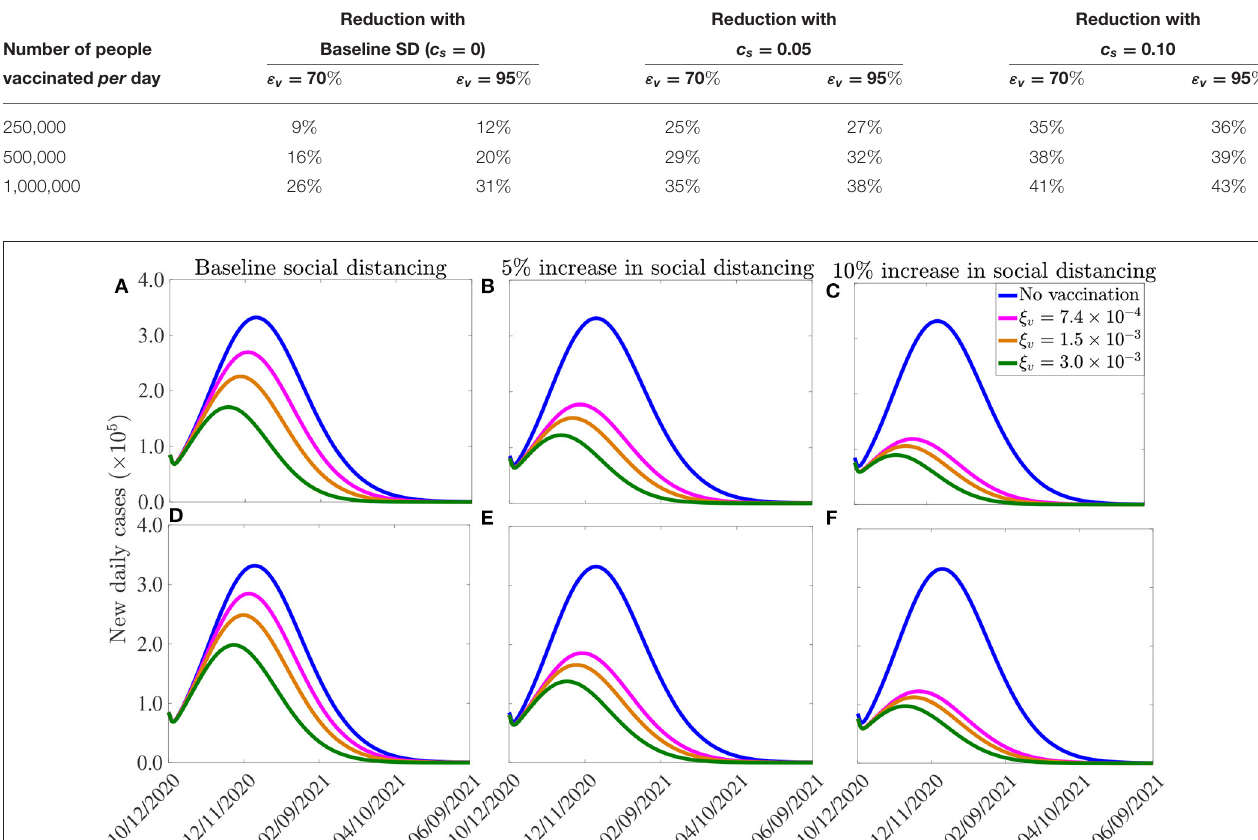
TABLE 6 | Percentage reduction in projected cumulative COVID-19 mortality on April 10, 2021, in relation to the cumulative mortality in the absence of vaccination (511,100 COVID-19 deaths on April 10, 2021), for the three vaccines considered in this study: AstraZeneca vaccine (efficacy ε v = 0.7); Pfizer and/or Moderna vaccine (efficacy ε v = 0.95), and various levels of increases in baseline social-distancing compliance attained on October 12, 2020 ( c s ) and vaccination rate ( ξ v ). SD, social-distancing compliance.